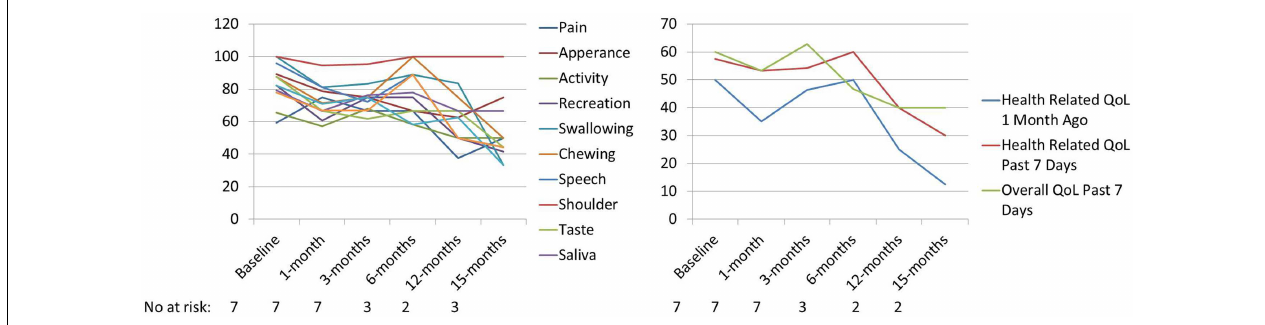
FIGURE 2 | Mean PRQoL values from baseline to 15months as assessed by UW-QoL-R . QoL: quality of life; No. at risk: number of patients at risk.